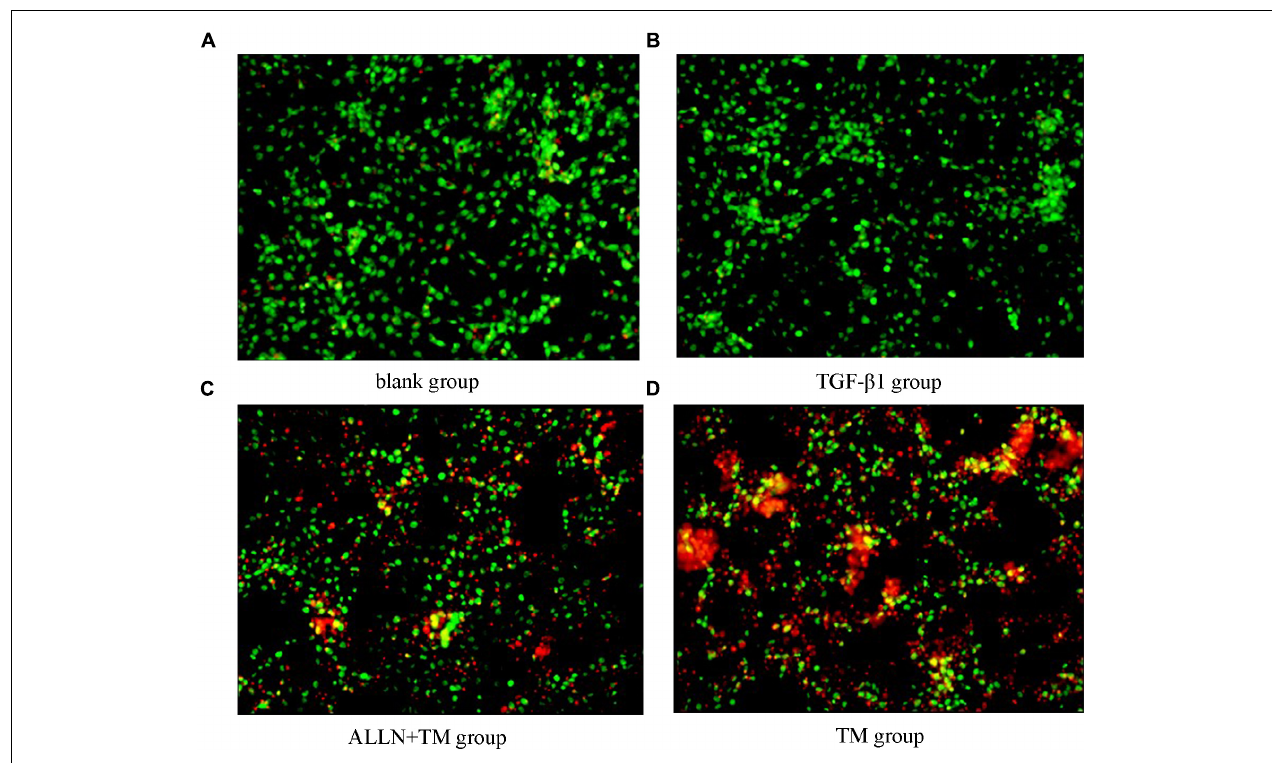
FIGURE 4 | Cell apoptosis was observed by AO/PI staining. Cell apoptosis was detected by staining with acridine orange/propidium iodide (AO/PI) after treatment with TGF- β 1, ALLN, and TM in HSC. (A) Blank group. (B) TGF- β 1 group. (C) ALLN + TM group. (D) TM group. Green fluorescence represented survival, and red or orange represented